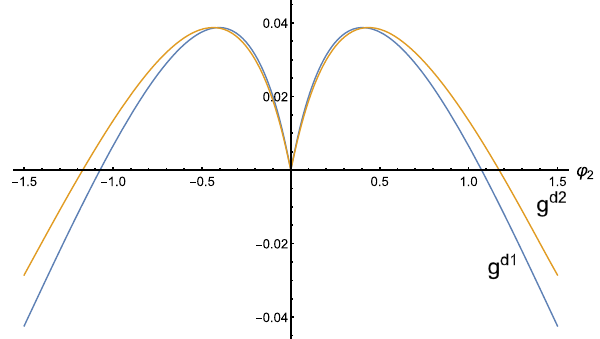
Fig. 5 Thetwolowerboundsaremaximallyviolatedon θ s = 1 . 18208, ϕ = 0. Shown here are the dependence of g d 1 (θ 1 0 ,ϕ 2 ) and g d 2 (θ s = 1 . 18208 ,ϕ 1 = 0 ,ϕ 2 ) on ϕ 2 . g d 1 > 0 when 0 < | ϕ 2 | < 1 . 0734, while g d 2 > 0 when 0 < | ϕ 2 | < 1 .